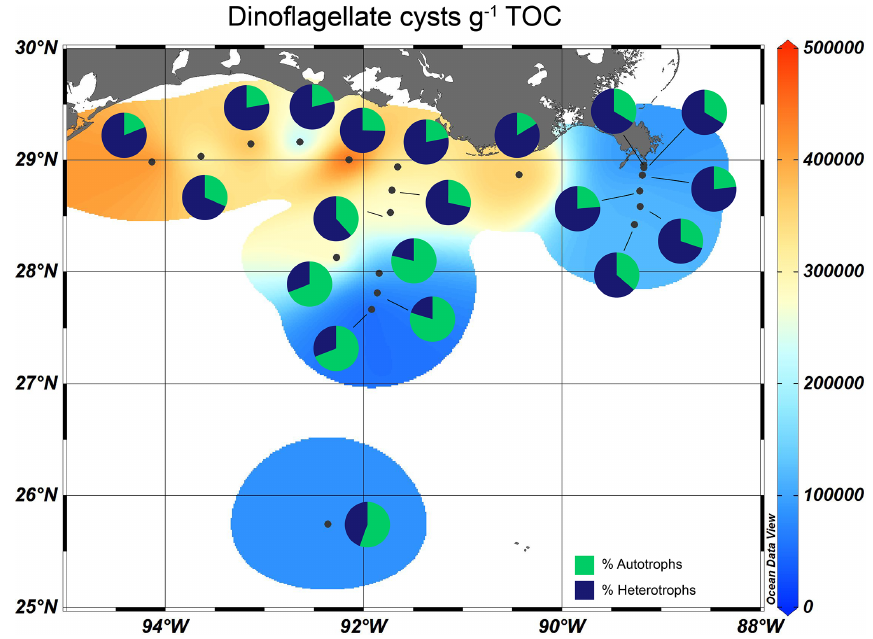
Figure 8. Isosurface plots of the TOC-normalized dinocyst concentration in GoM surface sediments overlain by pie charts showing the relative contribution of autotrophic and heterotrophic